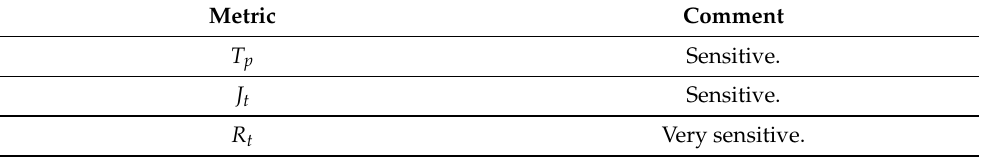
Table 13. Summarized RSA-based qualitative assessment of SDN metrics (sensitivities).